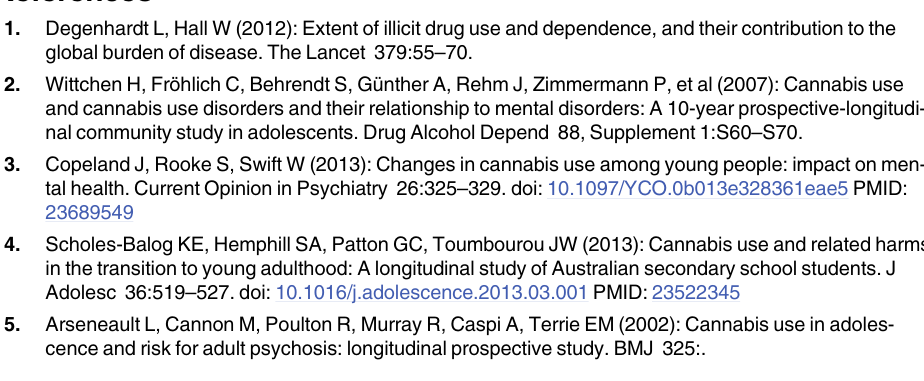
S1 Table. A. Overview of the findings of the baseline paper (Cousijn et al. 2012) and the current paper (Koenders et al., 2016). Consistent findings are printed in bold. Note: CB = cannabis group; HC = healthy control group; CUDIT = Cannabis Use Disorder Identifi- cation Test; n.s. = not significant; x,y,z = MNI coordinates. B. Overview of our results of the complete sample and of the control analyses. Consistent findings are printed in bold. Note: CB = cannabis group; HC = healthy control group; CUDIT = Cannabis Use Disorder Identifi- cation Test; n.s. = not significant; x,y,z = MNI coordinates; a CB group N = 20, HC group N = 22; b CB group N = 14; HC group N =